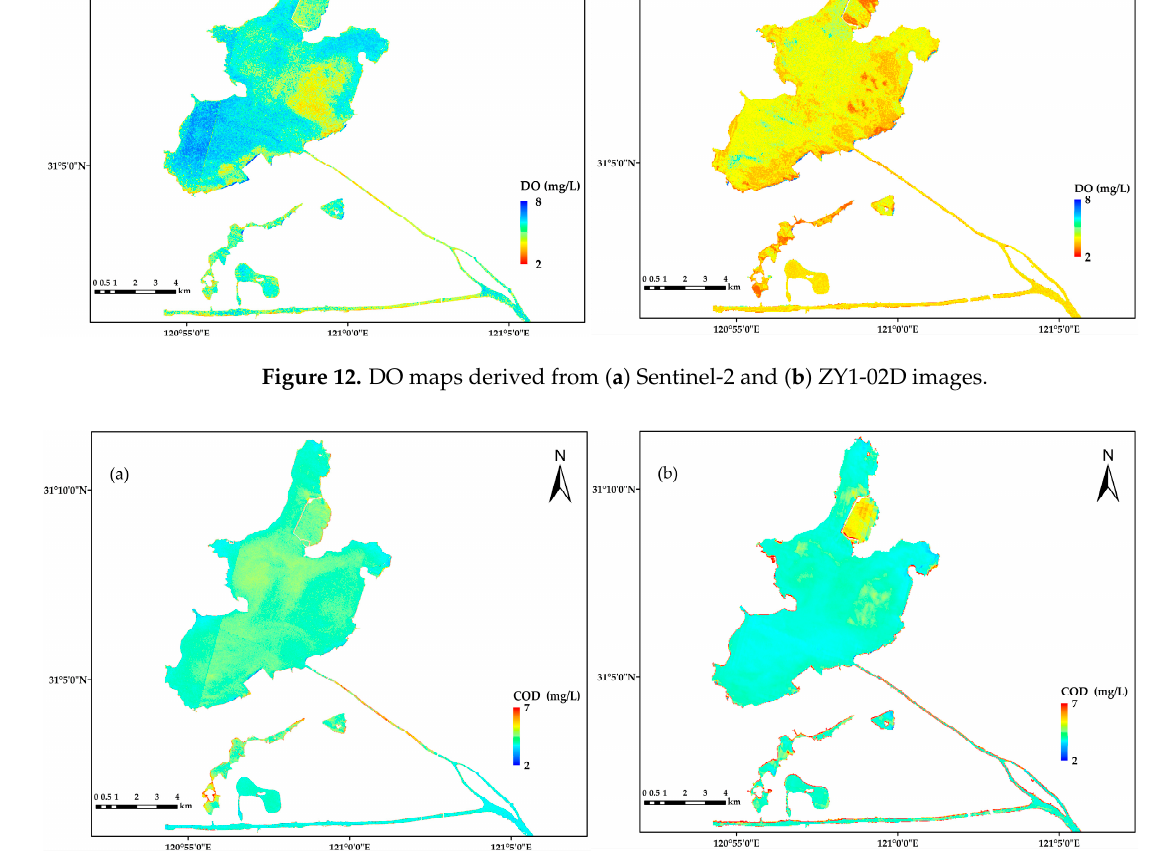
Figure 13. COD Mn maps derived from ( a ) Sentinel-2 and ( b ) ZY1-02D images.